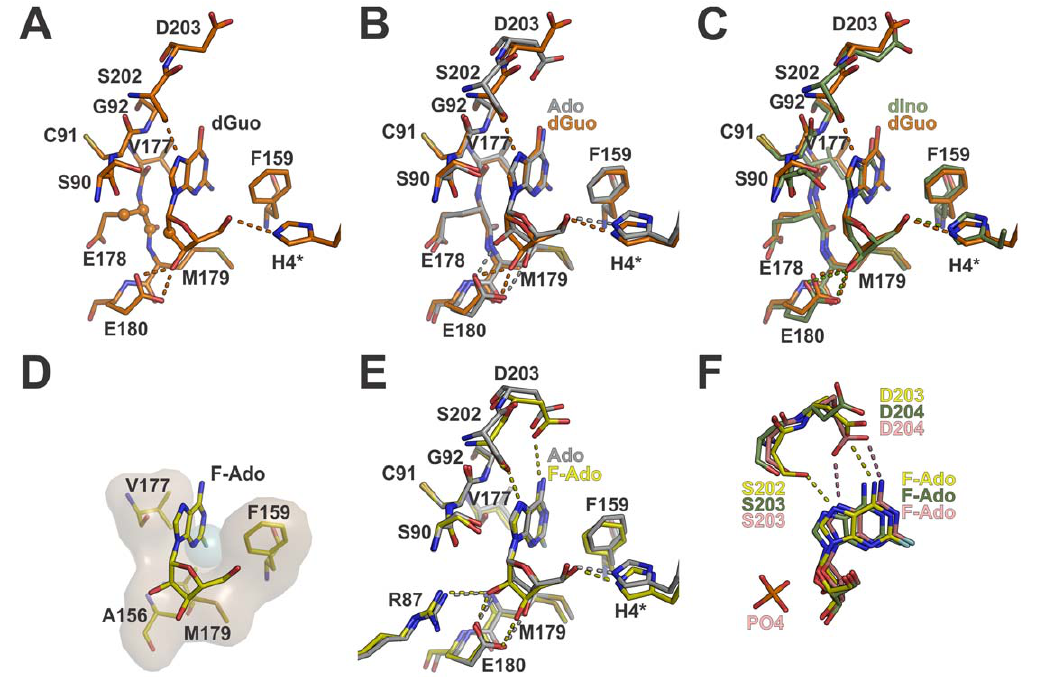
Figure 4. The binding mode of 2 9 deoxyguanosine and 2-fluoradenosine. A. Representation of the BsPNP233 residues that interact with dGuo showing as spheres the atoms involved in hydrophobic interactions with dGuo C 2 9 atom. B. Structural alignment between the dGuo-complex (carbon atoms in orange ) and the Ado-complex (carbon atoms in grey ). C The structure of dGuo-complex and TvPNP-(2 9 -deoxyinosine) complex (carbon atoms in green , PDB code 1Z39, [51]) are superimposed. D. Representation of F-Ado complex showing the residues involved in van der Waals interactions with F 2 atom ( light blue sphere). E. Structural comparison of F-Ado complex (carbon atoms in yellow ) with the Ado-complex (carbon atoms in grey ). F. The structures of F-Ado complex, EcPNP-F-Ado-PO 4 complex (carbon atoms in pink , PDB code 1PK9 [54]) and TvPNP-F-Ado complex (carbon atoms in green , PDB code 1Z35, [51]) are superimposed. In all panels hydrogen bonds are represented by dashed lines and color coded according to their respective